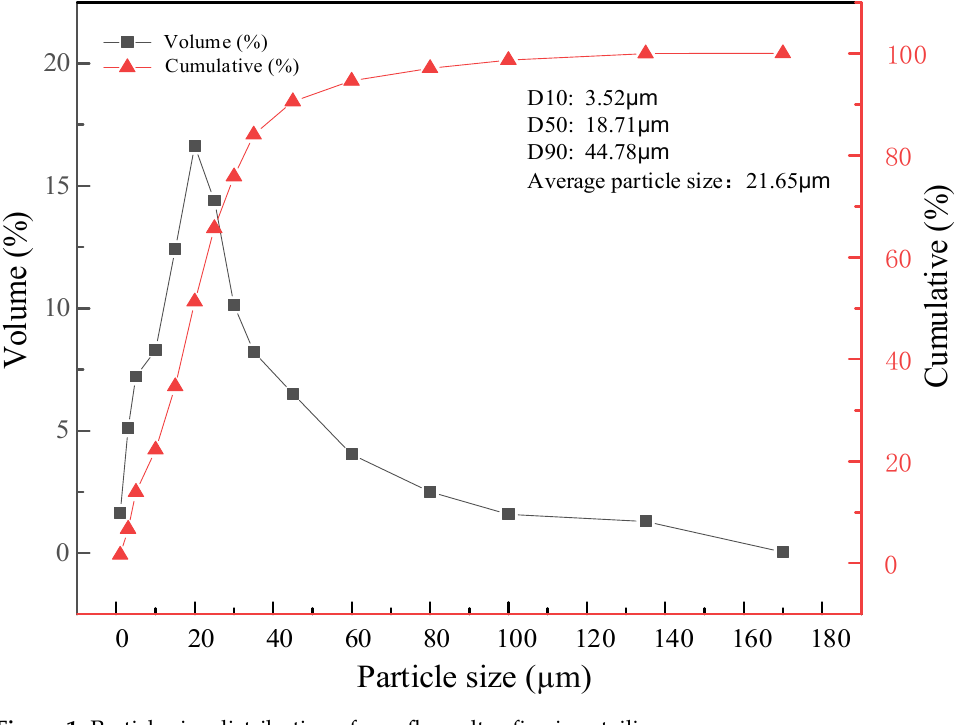
Figure 1. Particle size distribution of overflow ultra-fine iron tailings.